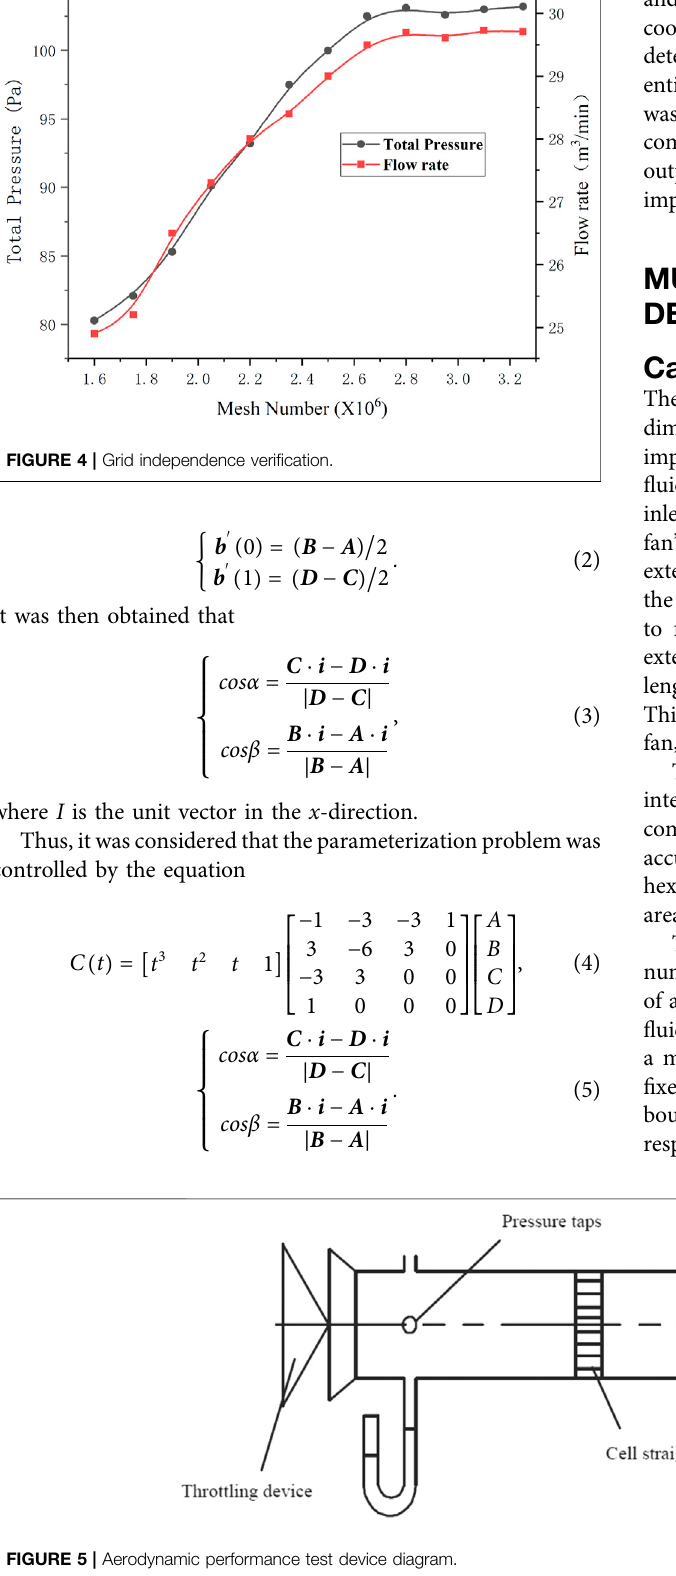
FIGURE 5 | Aerodynamic performance test device